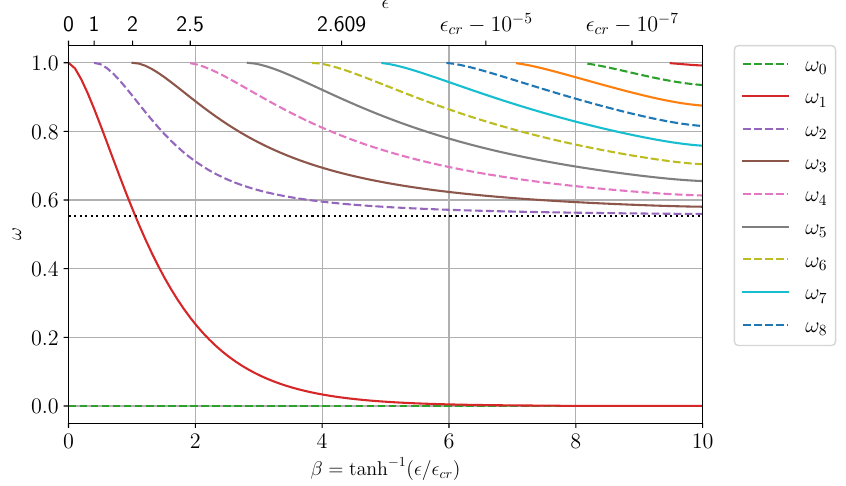
Figure 5 . The eigenfrequency of the internal modes ω as a function of the deformation parameter (cid:15) = (cid:15) cr tanh( β ) . Dashed lines correspond to even modes. The dotted line shows m 1 ( (cid:15) cr ) , the mass associated with small perturbations of the false vacuum at (cid:15) = (cid:15) cr